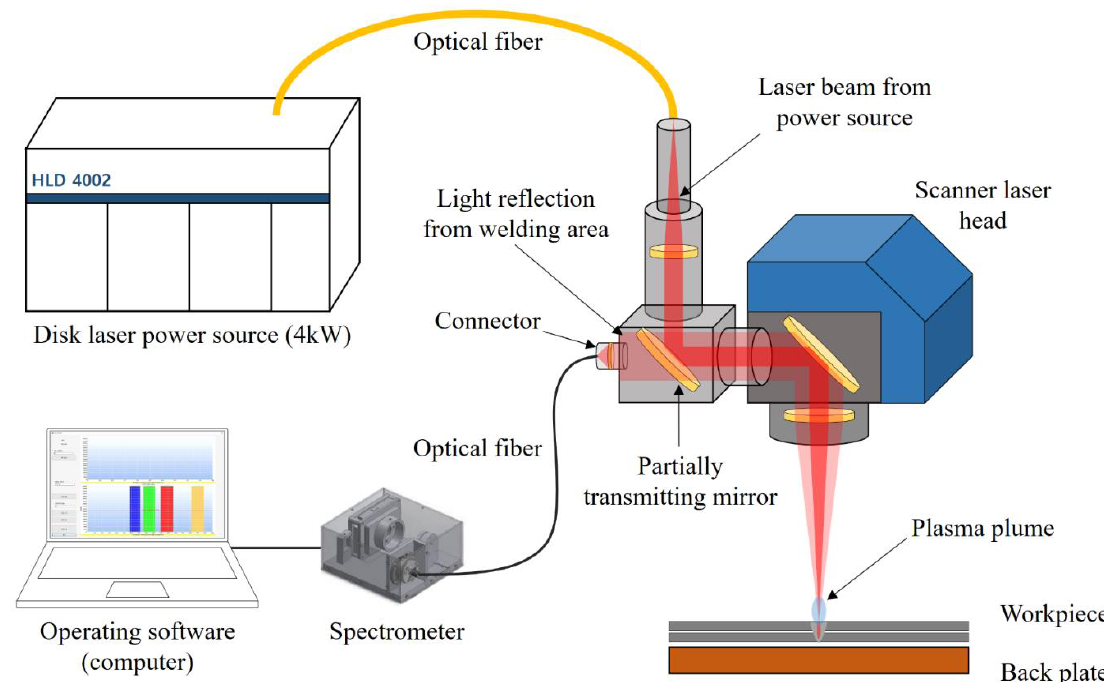
Figure 2. Schematic of experimental setup.